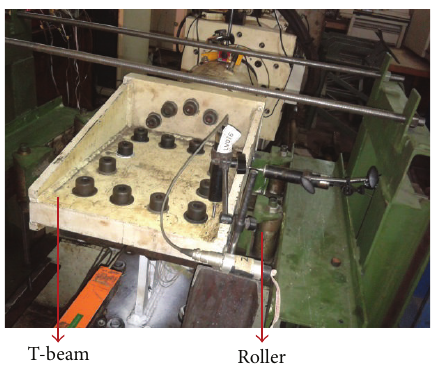
Figure 8: Top view of experimental